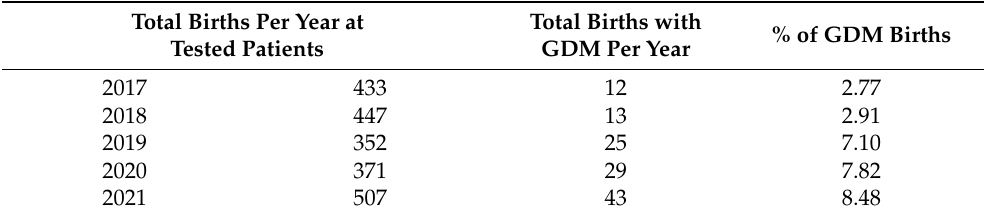
Total Births with % of GDM Births GDM Per Year